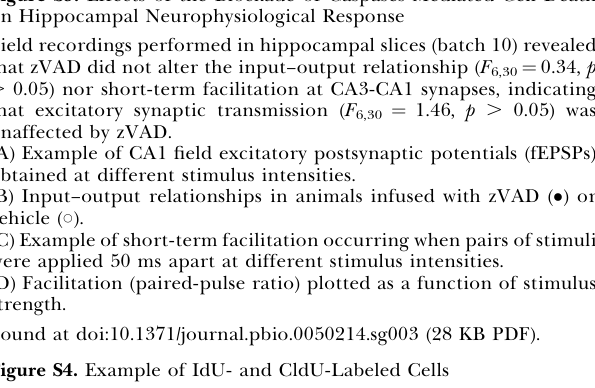
Figure S4. Example of IdU- and CldU-Labeled Cells